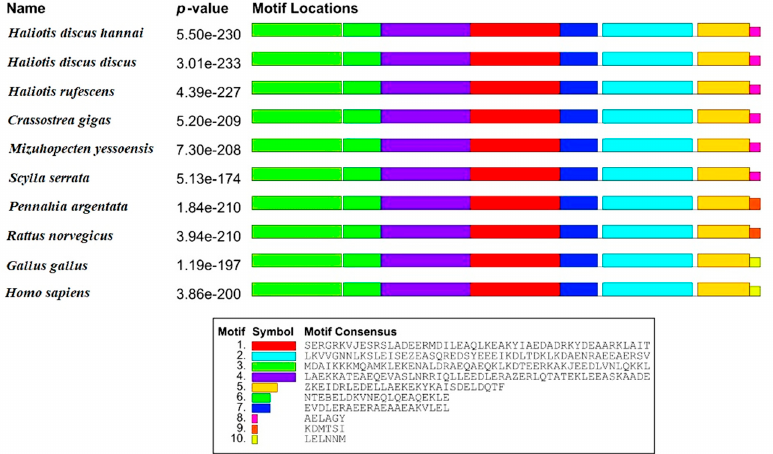
Figure 2. Schematic diagram of the motifs detected in Hdh-TPM and other TPM of invertebrates and vertebrates. Distinct motifs are denoted by different colors. The motif analysis included the TPM sequence of H. discus hannai and TPM sequences of other species: H. discus discus (BAH10148.1), H. rufescens (CAA53028.1), Crassostrea gigus (ARX70262.1), Mizuhopecten yessoensis (ACF22883.1), Scylla serrata (ABS12233.1), Pennahia argentata (BAB20881.1), Rattus norvegicus (AAA42263.1), Gallus gallus (NP_990732.1), and Homo sapiens (AAT68295.1). rufescens , Crassostrea gigas , Danio rerio , Xenopus laevis , Orcinus orca , Rattus norvegicus , and Homo sapiens (Figure 3). The signature motifs of the invertebrates were the same; however,